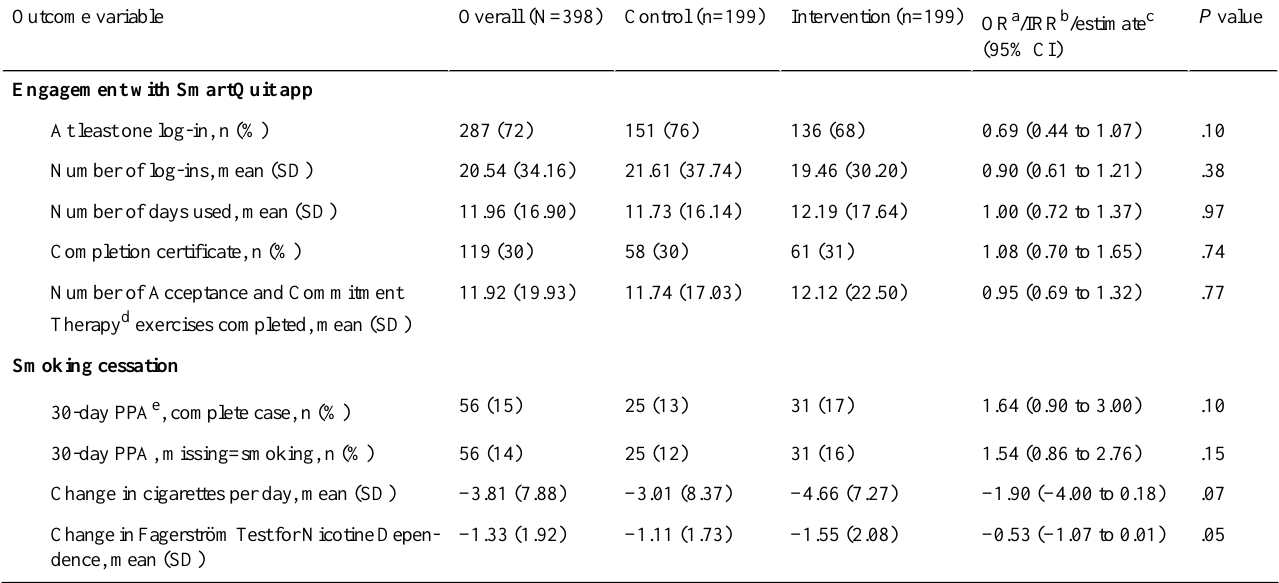
Table 2. Smoking cessation and engagement with cessation program at 2-month follow-up. Results are adjusted for 2 stratification factors (heavy smoking and education). Cessation results are adjusted for baseline